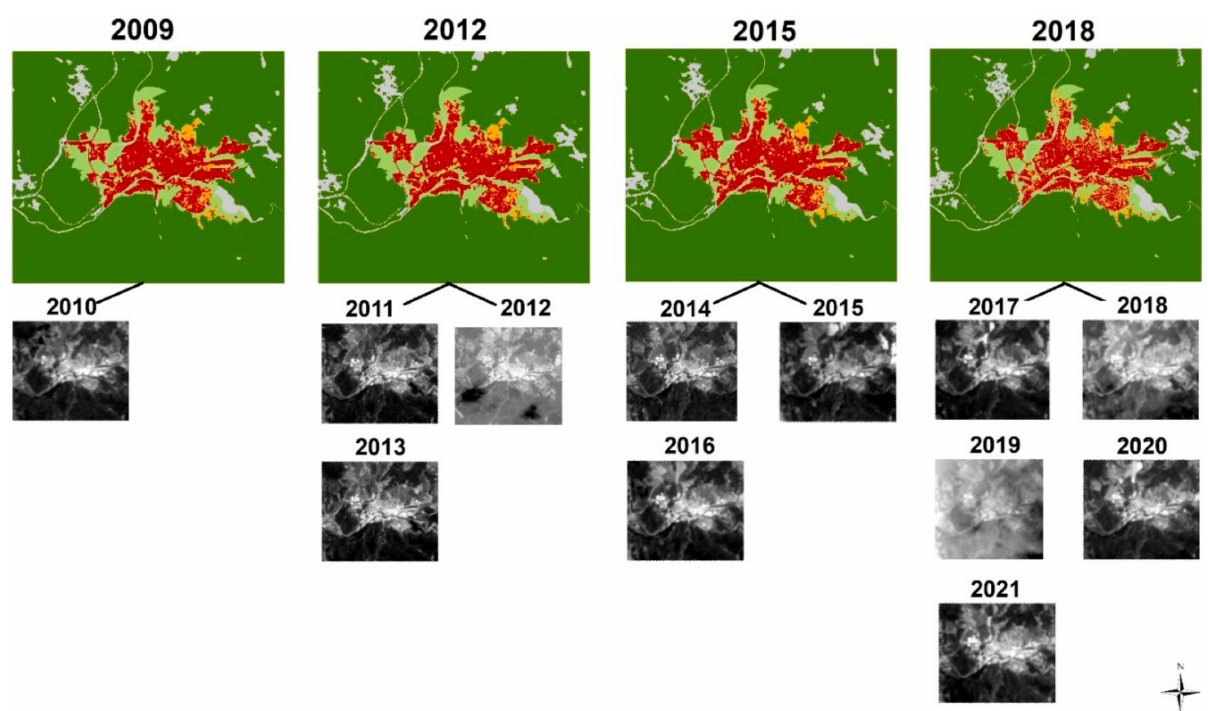
Figure 3. Assignment of LST calculated from Landsat images of a specific year to urban zones defined based on the Copernicus imperviousness density data according to the year closest to the evaluated